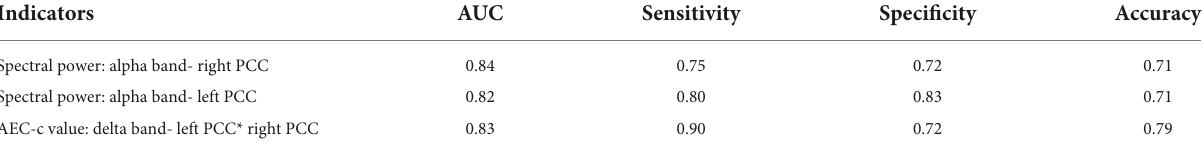
TABLE 3 Metrics for logistic regression